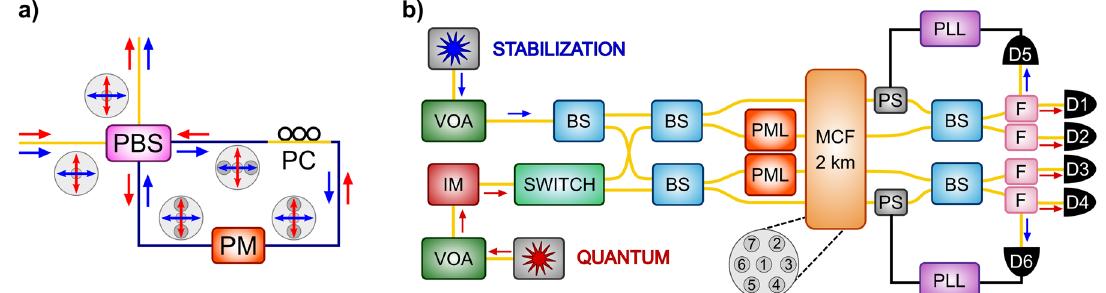
fringes induced by the board are visible, as the signal is not phase modulated.